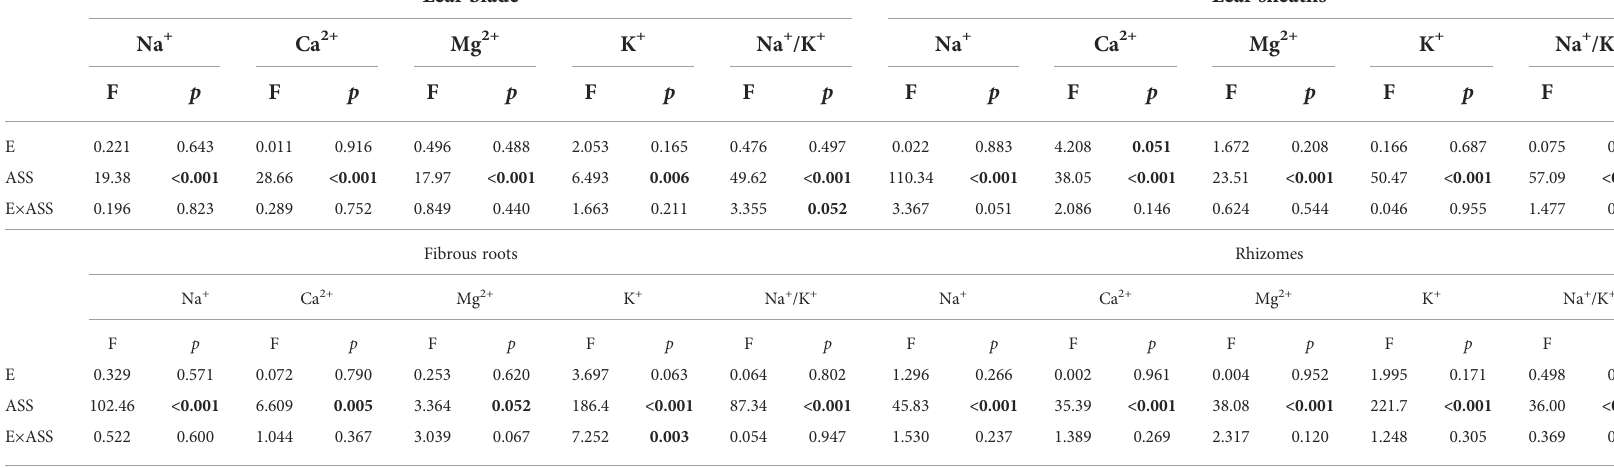
TABLE 6 ANOVA results for the effect of endophyte status and alkali salt stress on ion contents and K + /Na + ratio in shoots and